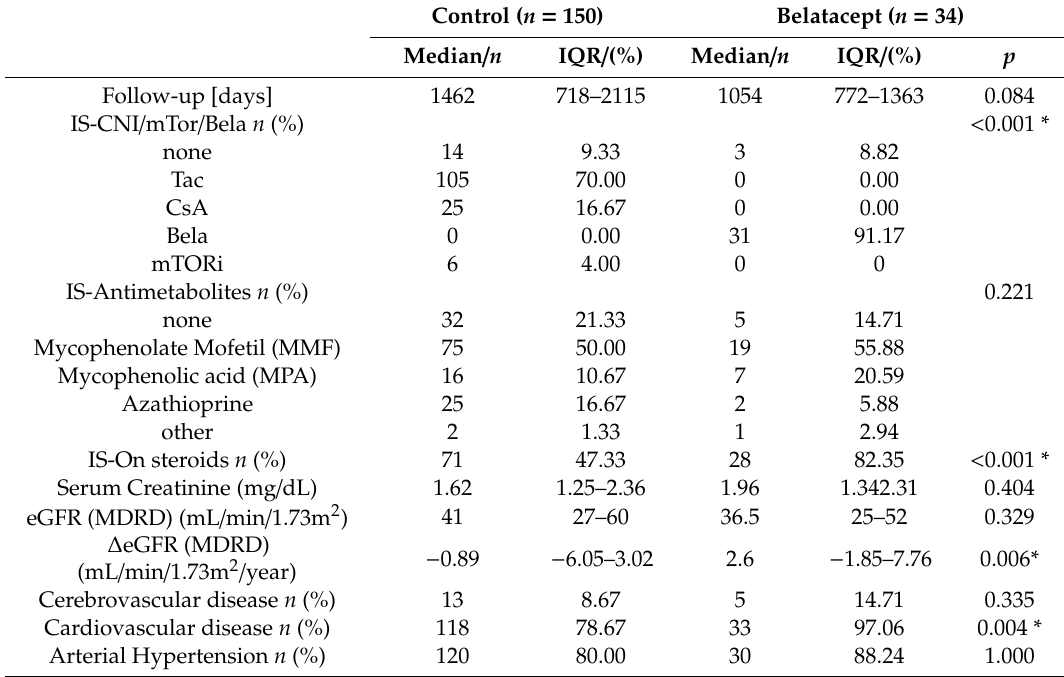
Table 3. Data at last